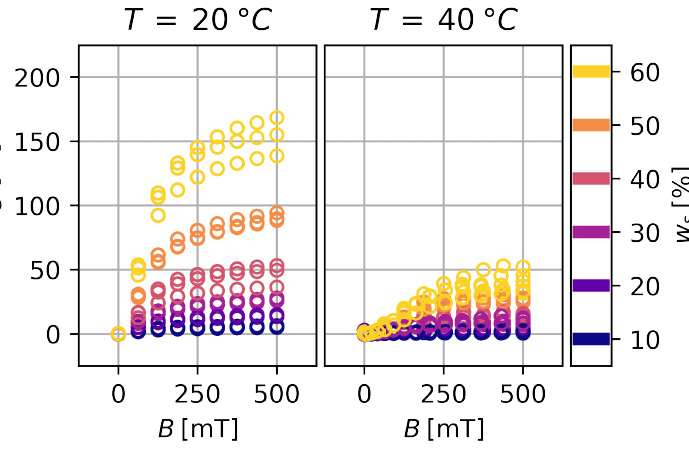
Figure 7. Magnetorheological effect of the storage modulus over the magnetic flux density for gels with different mass fractions of particles in the initial state for the first batch of gels. Three samples per w s are shown. Error bars are smaller than the